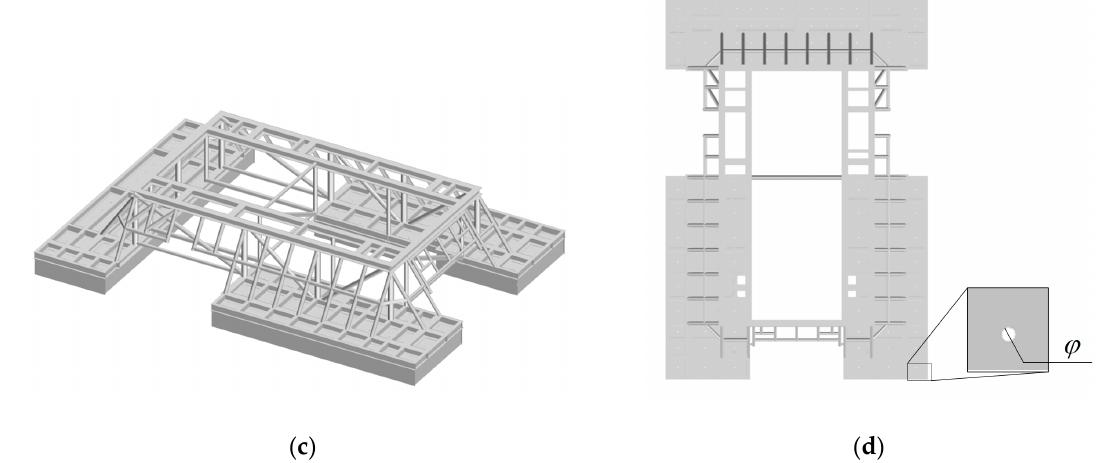
Figure 2. Principal layout of the test module: ( a ) side view, (b) front view, ( c ) isometric drawing, ( d ) top view.